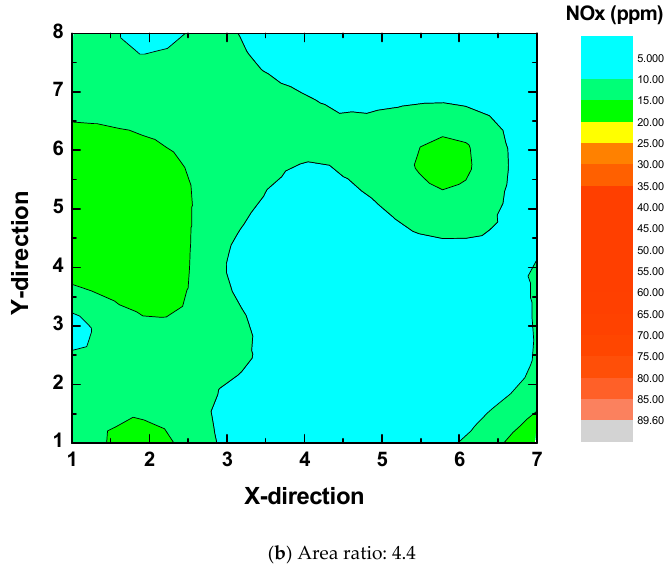
Figure 10. NOx distribution in relation to the variations of 8.8 and 4.2 of area ratios.